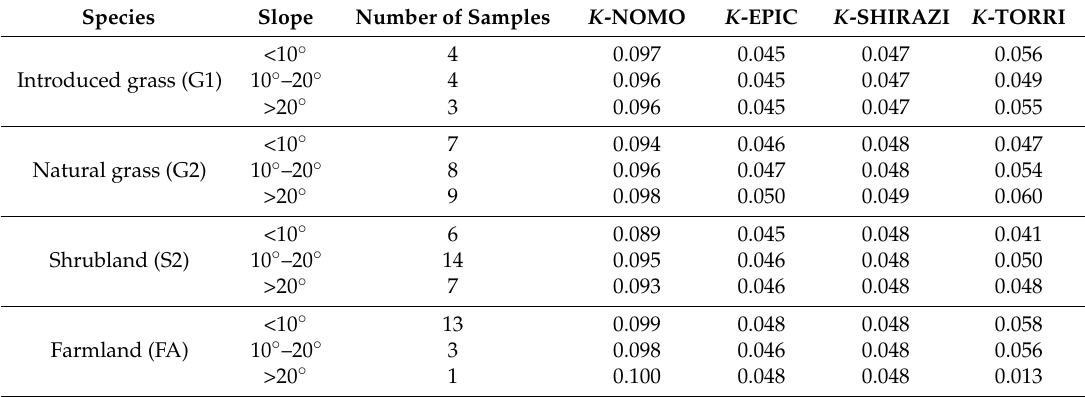
Table 2. The estimated value of K used to compare models at Ansai catchment (t · hm 2 · h/(MJ · mm · hm 2 )). Species Slope Number of Samples K